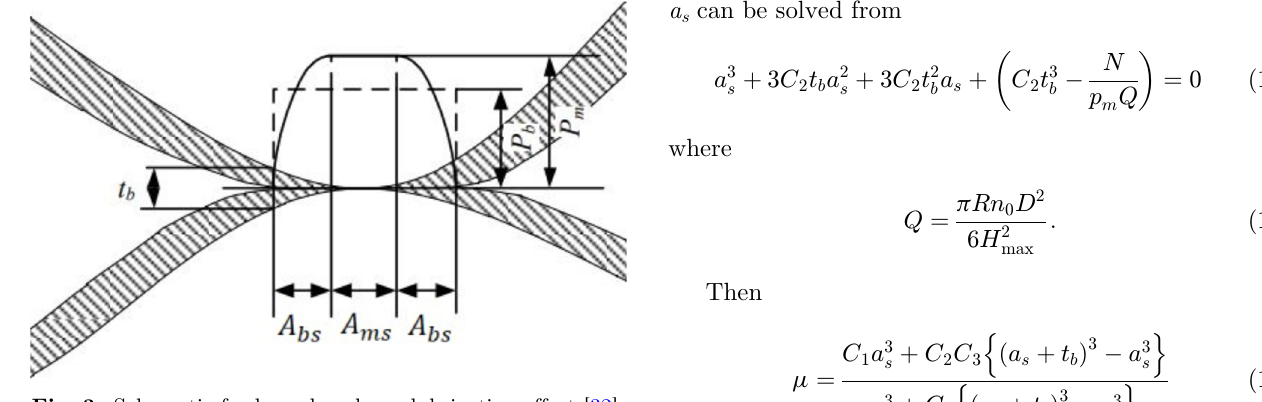
Fig. 3. Schematic for boundary layer lubrication